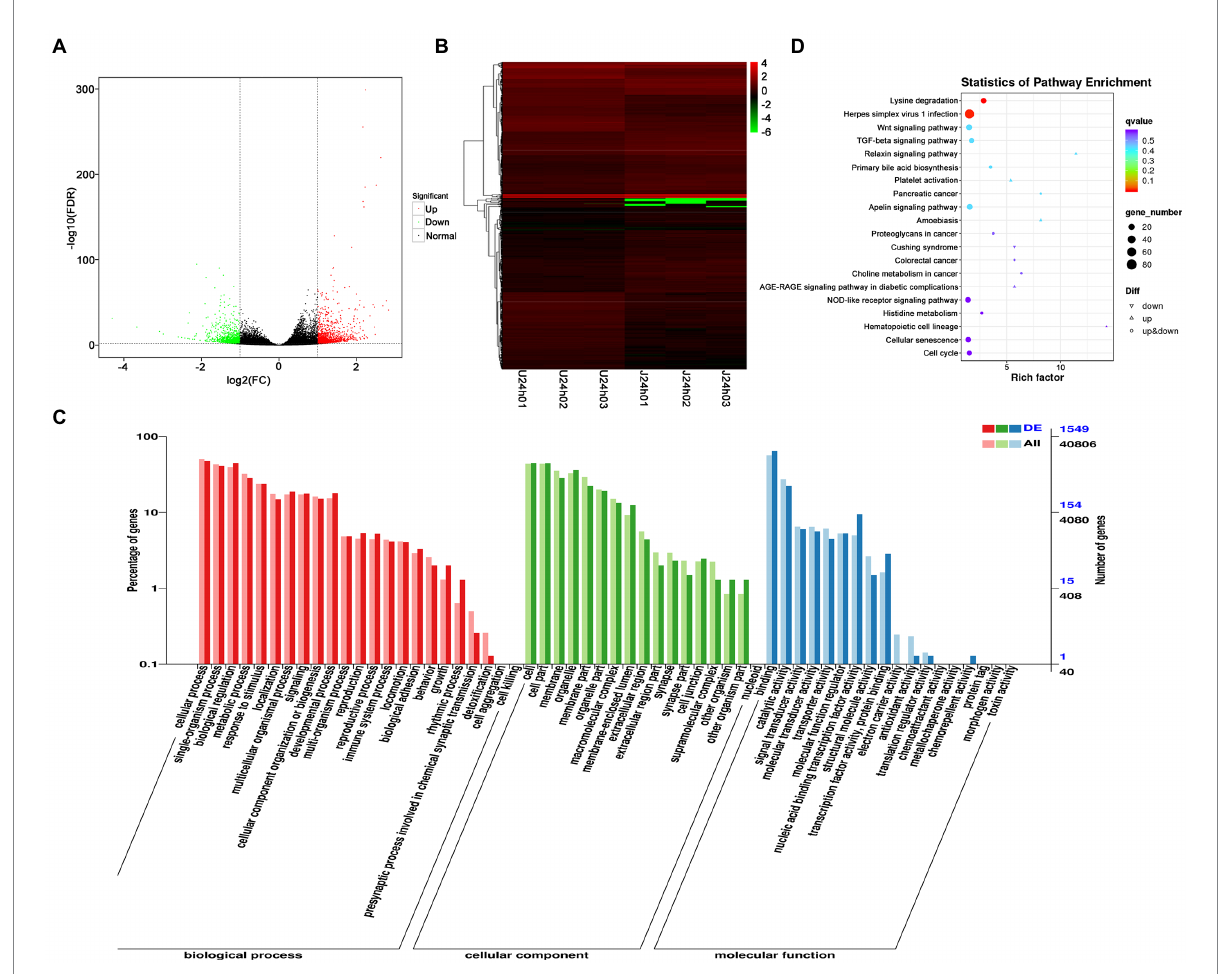
FIGURE 4 Comparison and enrichment analysis of DEGs in the U versus J-IHNV infection groups. (A) Volcano plot of DEGs. (B) Hierarchical clustering analysis of DEGs. (C) GO enrichment of DEGs. (D) KEGG enrichment analysis of